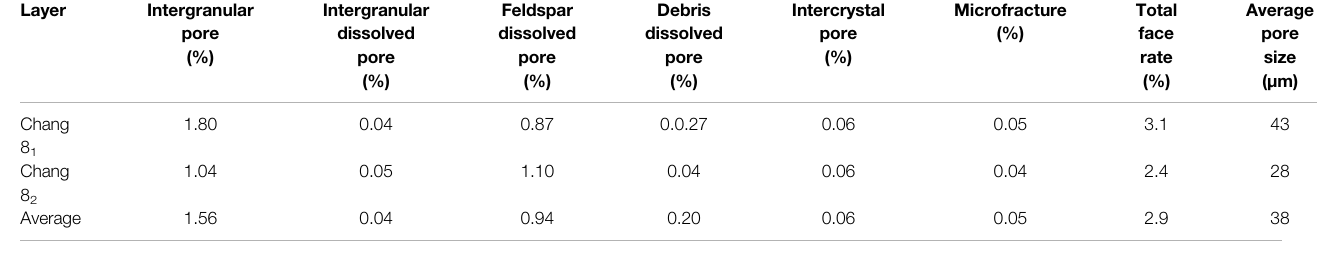
TABLE 3 | Pore types of Chang 8 reservoir in Wuqi – Zhijing – Ansai area. Layer